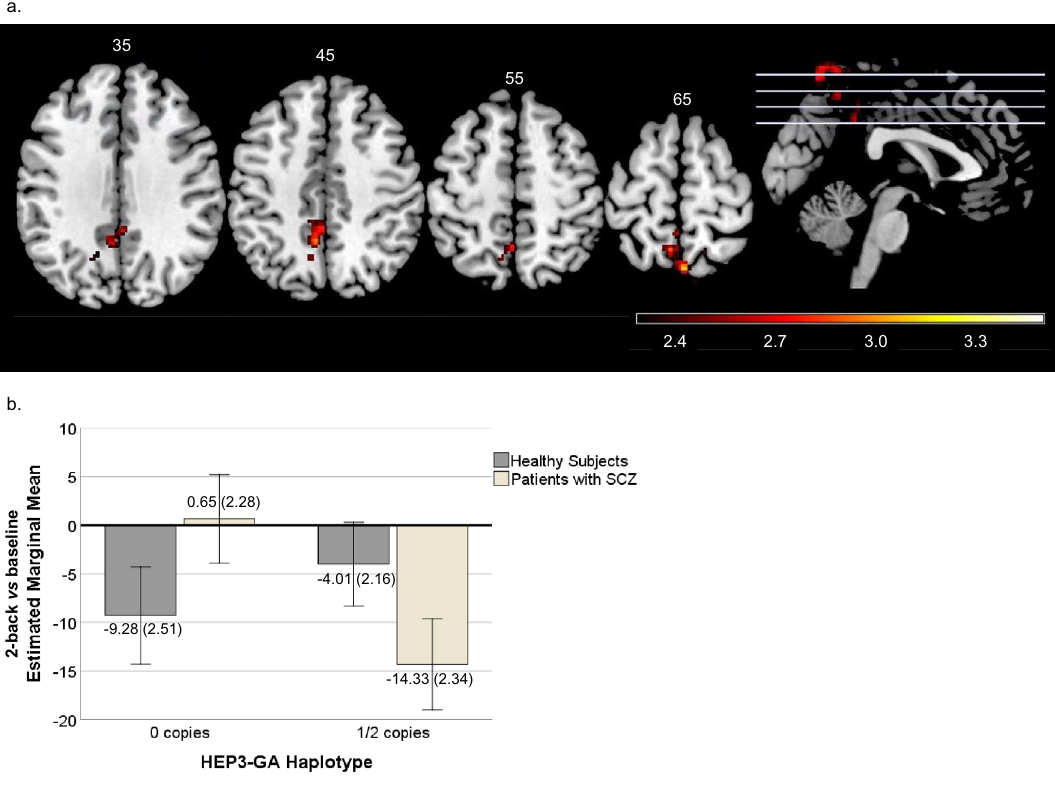
Figure 1. ( a ) Brain regions showing the axial view of the cluster with significant diagnosis × HEP3-GA interaction in 2-back vs baseline contrast. The right side of the image represents the right side of the brain. The MNI coordinates are given for each slice. Units of the bar are the corresponding β values from the regression standardised to Z-scores. ( b ) Plot with the corresponding estimated marginal mean activity scores and ± 2 standard error (SE) for HEP3-GA haplotype in healthy subjects (42.90% with 0 copies and 57.10% with 1 or 2 (1/2) copies) and patients with SZ (51.40% with 0 copies and 48.60% with 1or 2 (1/2)